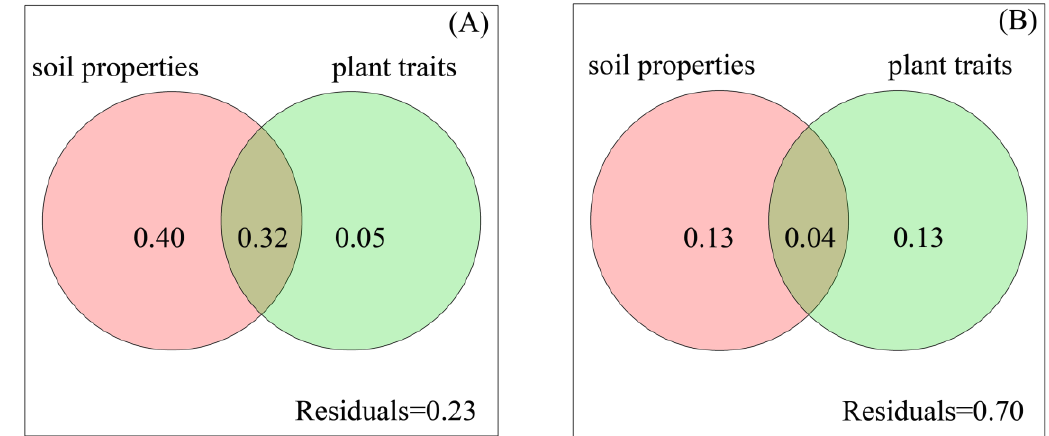
Figure 6. The proportions of variation at genus level in composition of soil bacterial community ( A ) and soil fungal community ( B ) composition explained by soil and plant variables.4. Discussion.